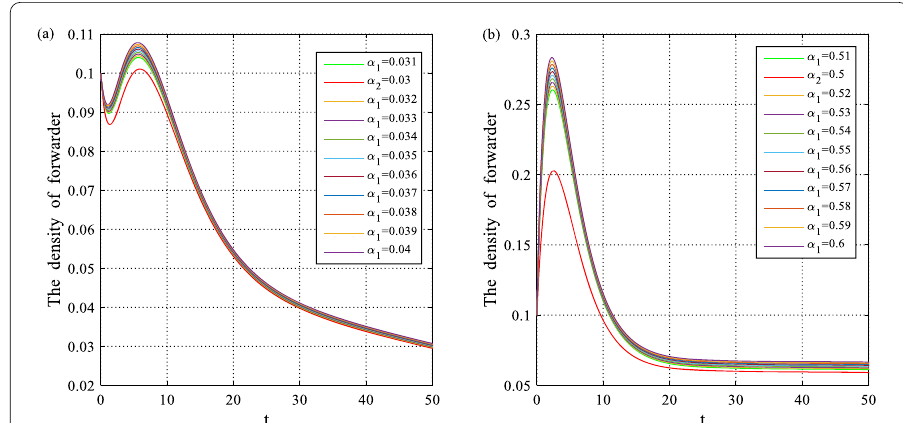
Figure 11 The density of F 1 and F 2 under different α 1 , α 2